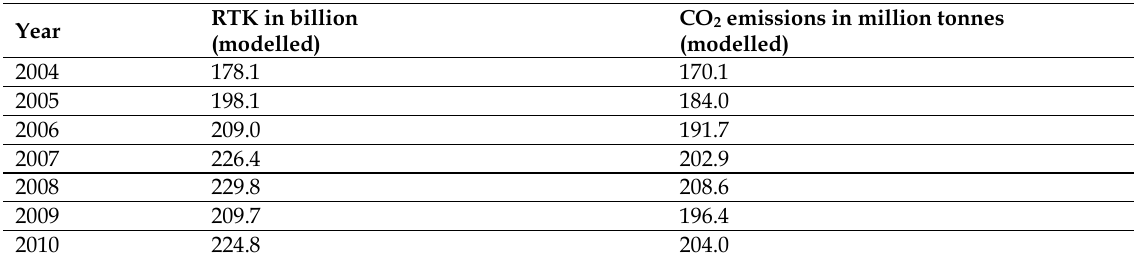
Table 1. Historical transport performance und CO 2 emissions of flights to and from European